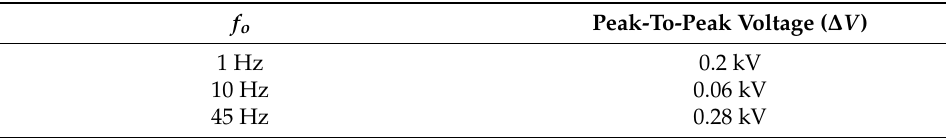
Figure 6. MMSC simulation results. ( a – c ) show the phase-A submodule-string insertion-index signal ( S ( t ) ) for the cases in which f o = 1,10 and 45 Hz, respectively. ( d – f ) show the phase-A string current ( i string ) for the cases in which f o = 1,10 and 45 Hz, respectively. ( g – i ) show the phase-A-string submodule-capacitor voltages ( v cap ) for the cases in which f o = 1,10 and 45 Hz, respectively. Table 3. MMSC submodule capacitor voltage